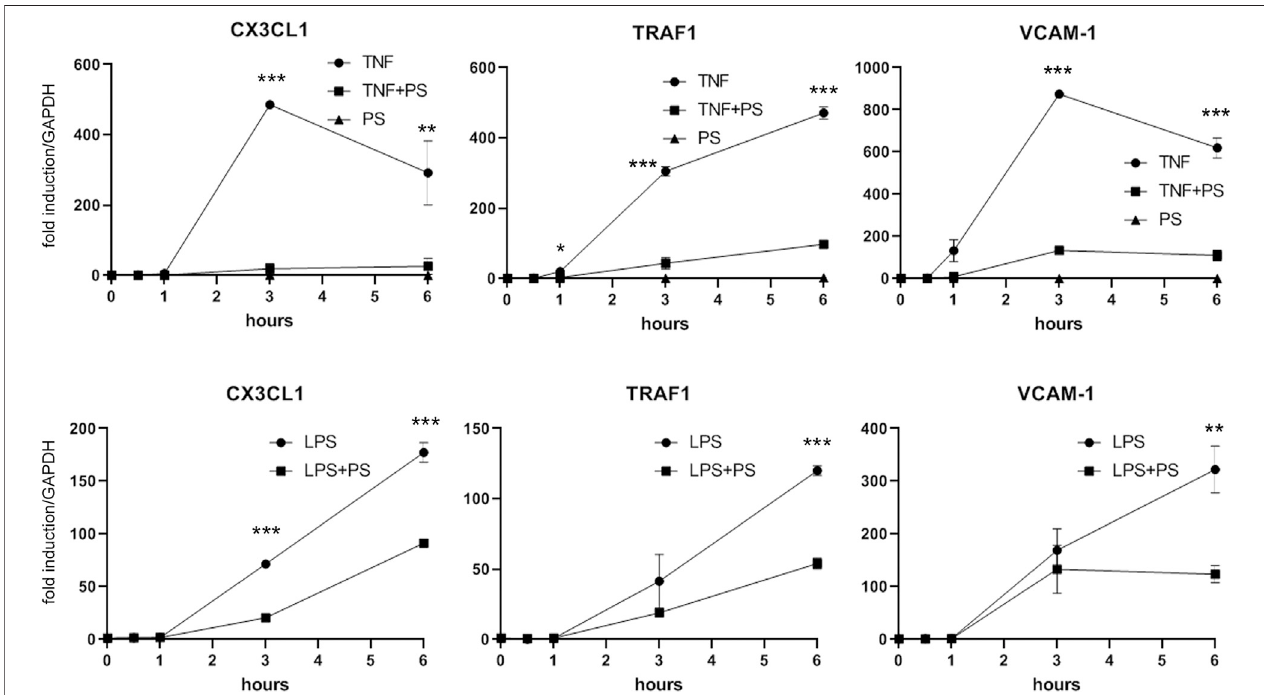
FIGURE 5 | PS suppresses the TNF- or LPS-stimulated expression ofCX3CL1, TRAF1, and VCAM-1. HUVEC were stimulated with 2.5 ng/ml TNF (upper panels) or 500 ng/mlLPS(lowerpanels) eitheraloneor afterpre-treatmentfor30 min with50 μ g/ml PSand analyzed byqPCR asindicated. *,**,and***indicate p < 0.05,0.01, and 0.001, respectively, of IL-1 + PS versus IL-1